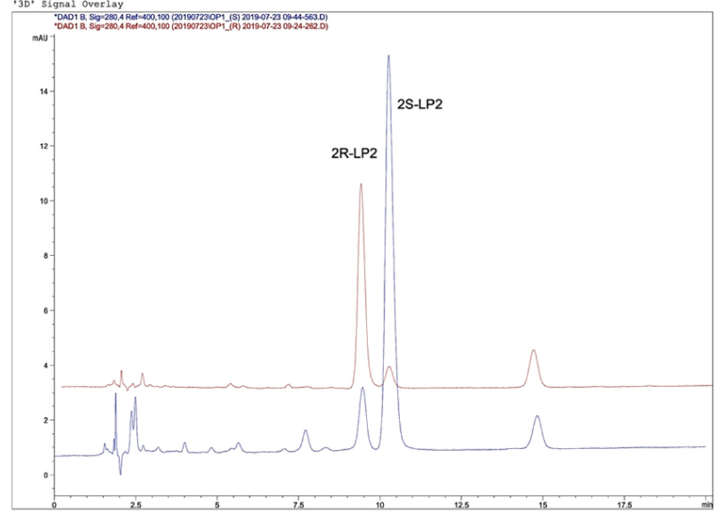
Figure 5. Chromatograms of 2 R ‐ LP2 and 2 S ‐ LP2.